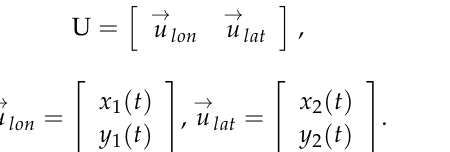
Figure 2. Vehicle representation through an oriented bounding box (OBB) model.